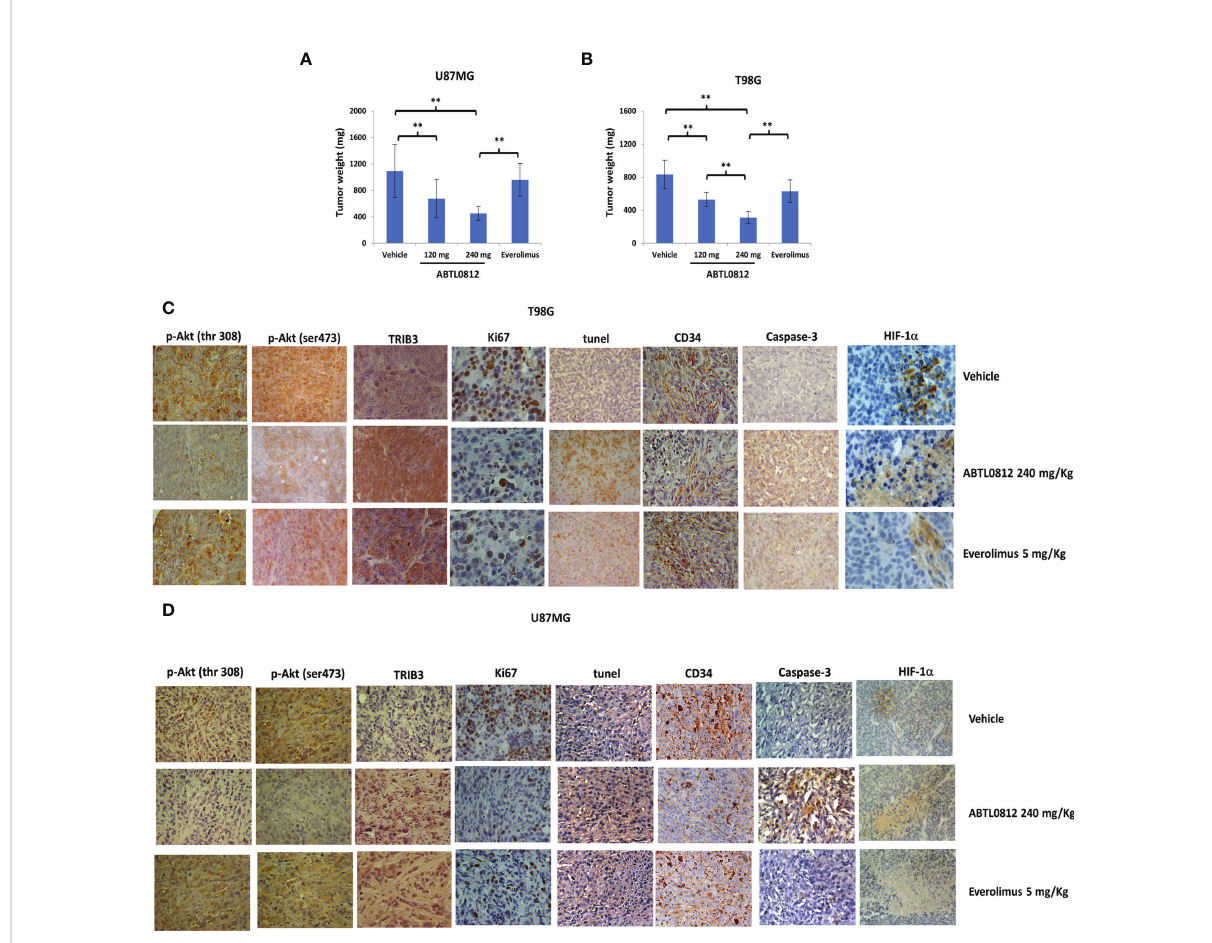
FIGURE 6 ABTL0812 impairs tumor growth in glioblastoma subcutaneous xenograft models. U87MG and T98G cells were injected subcutaneously in athymic female cd1 nu/nu mice (N=10 each group). Mice were treated daily with vehicle or ABTL0812 at 120 or 240 mg/Kg by oral administration. The mTORC inhibitor everolimus (ve) was used as a comparator for antitumor activity and was administered orally at dose of 5 mg/kg/2 days per week (A , B) Weight of U87MG and T98G cells-derived xenograft tumor removed from nude mice. (C , D) Representative immunohistochemistry images from U87MG (C) and T98G (D) xenograft tumors stained with Akt-mTORC axis markers (TRIB3, p-Akt Ser473 and p-Akt Thr308); the cell proliferation marker Ki67; the endothelial cell marker CD34; the apoptosis marker caspase3; the hypoxia marker HIF-1 a ; and TUNEL staining to measure apoptosis (Magni fi cation 400X). Statistical signi fi cance levels: *p<0.05, **p<0.01 and n =10. CTRL= control vehicle-treated